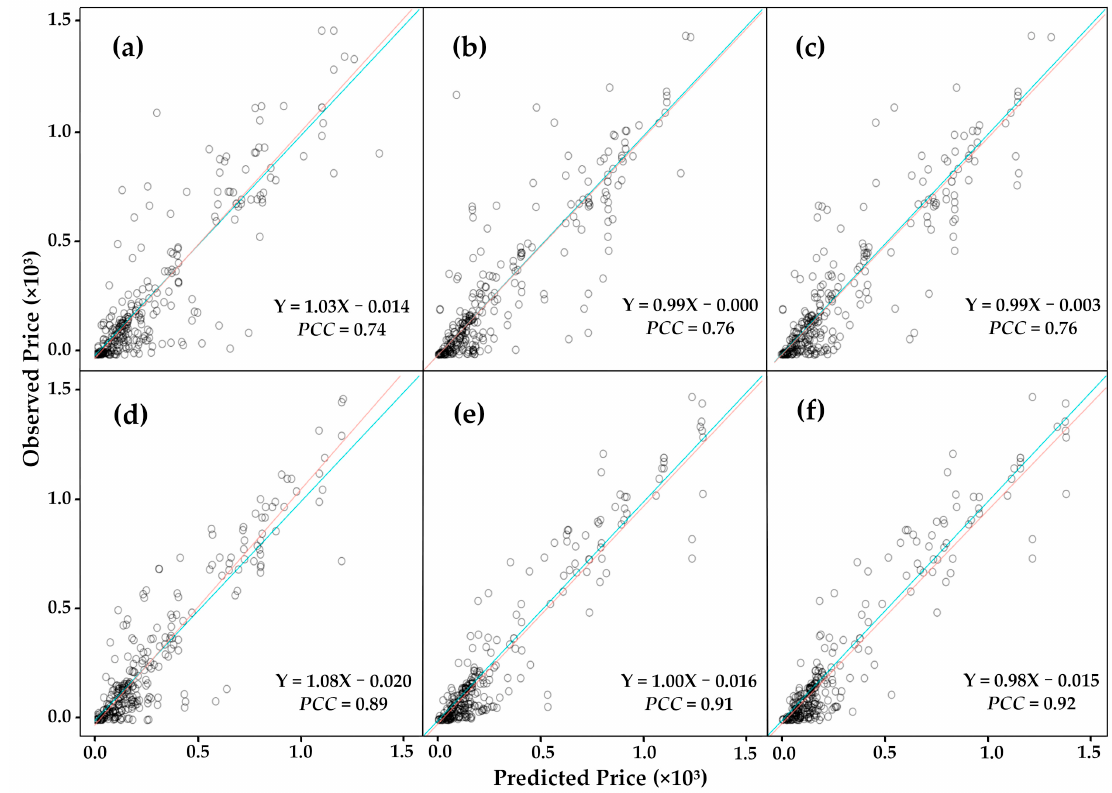
Figure 7. A set of examples for actual vs. predicted price scatterplots in one round of cross-validation. Panel ( a , d ), ( b , e ) and ( c , f ) correspond to the RFR-full, RFR-red-N and RFR-red-P models, respectively. Panel ( a – c ) represent the cross validation rounds with the poorest accuracy for each model, Panel ( d – f ) represent the cross validation rounds that have the highest accuracy for each model. The green dash lines in each panel are the 1-1 lines. The red solid lines in each panel are the best fit lines between actual and predicted water prices. The corresponding regression equations and Pearson correlation coefficients are given in each panel.